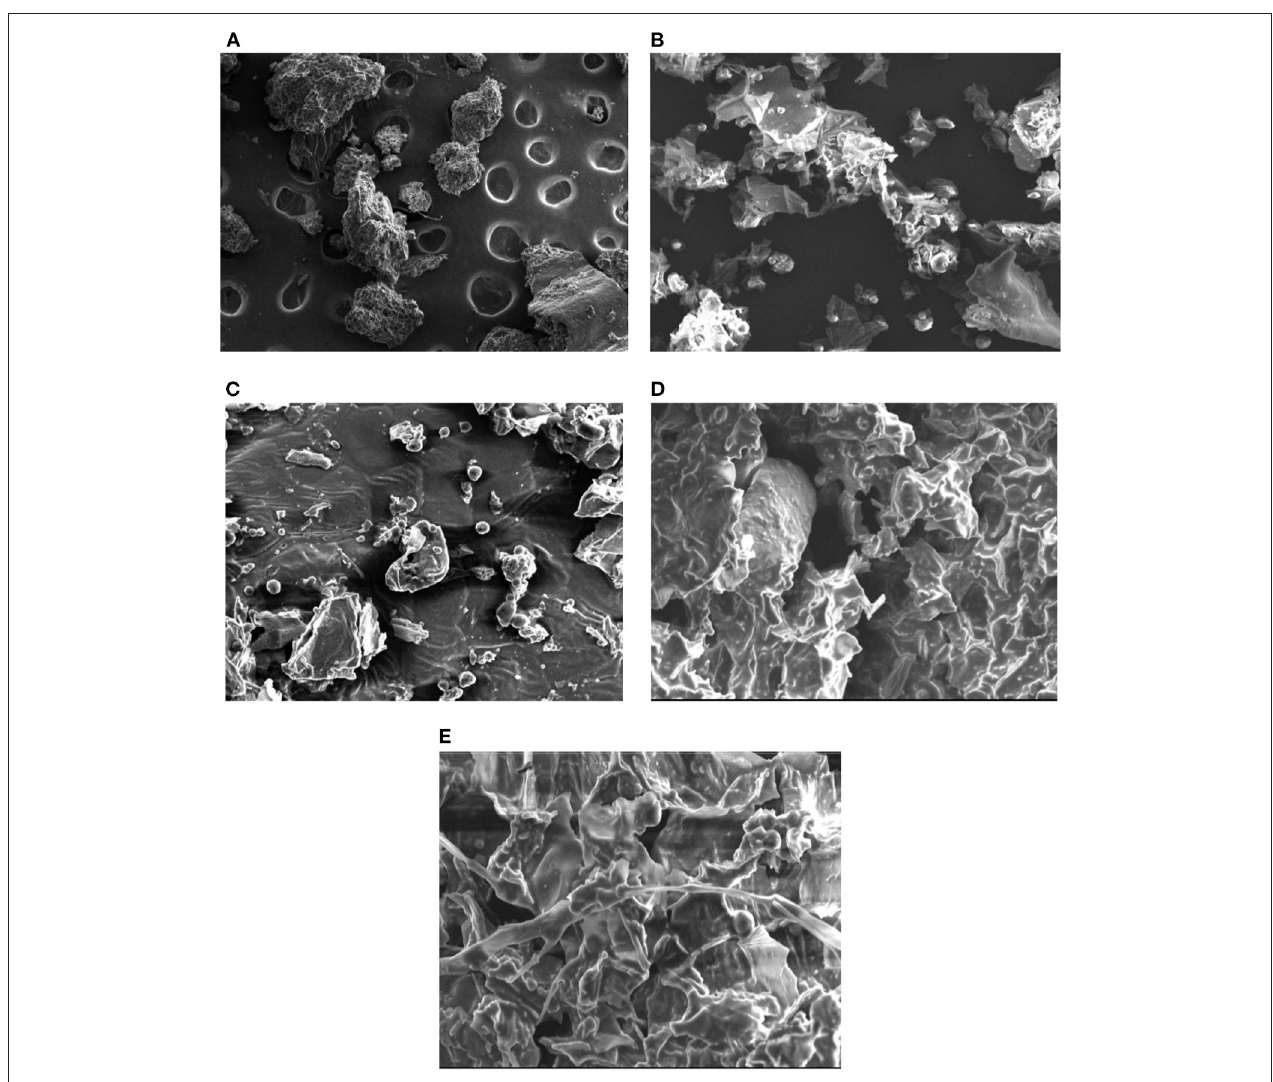
FIGURE 6 | Scanning electron micrographs of different samples (A) untreated (B) after maceration (C) after percolation (D) after UAE (E) after